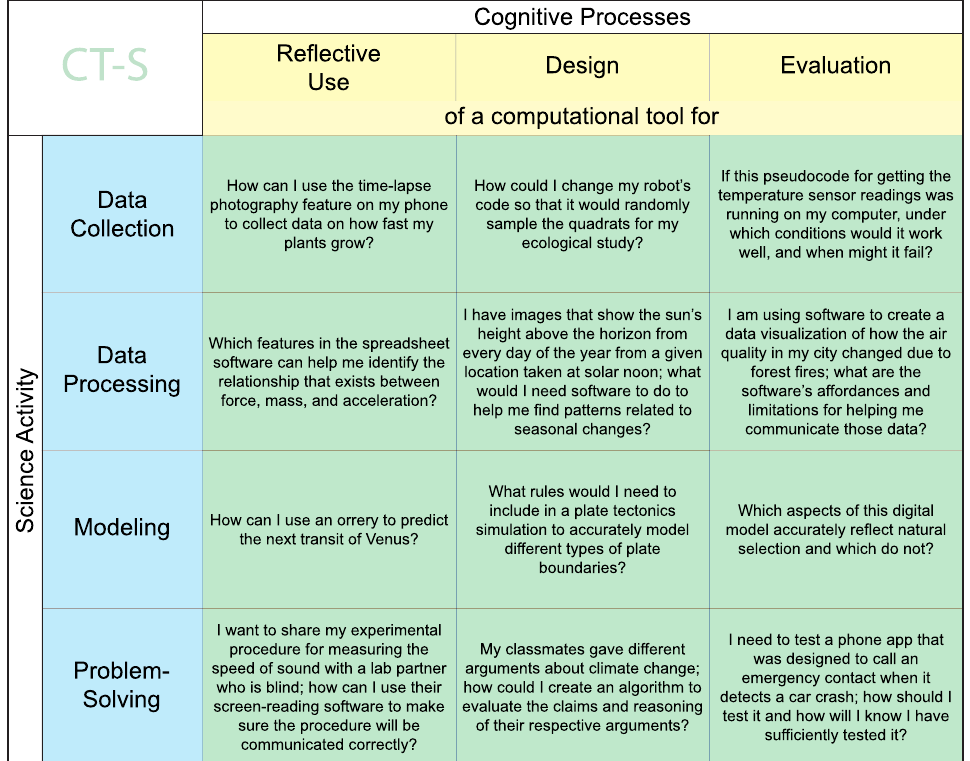
Fig. 2 The computational thinking for science framework with